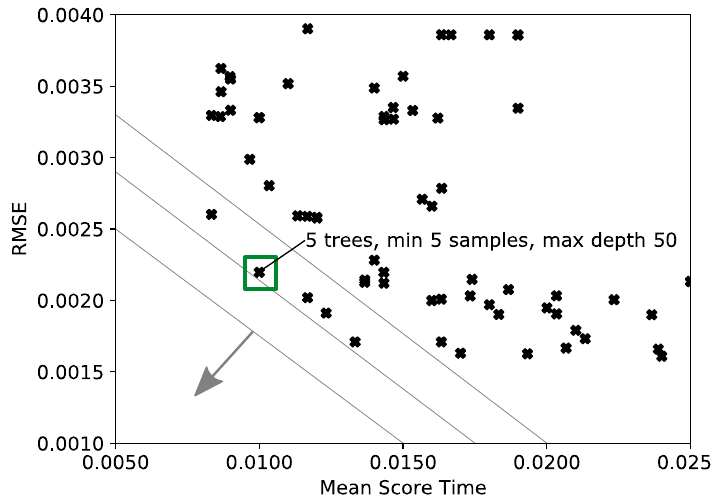
Figure 12. Hyper-parameter tuning of the random forest regression based on RMSE and mean- Figure 12. Hyper ‐ parameter tuning of the random forest regression based on RMSE and mean ‐ score time. score